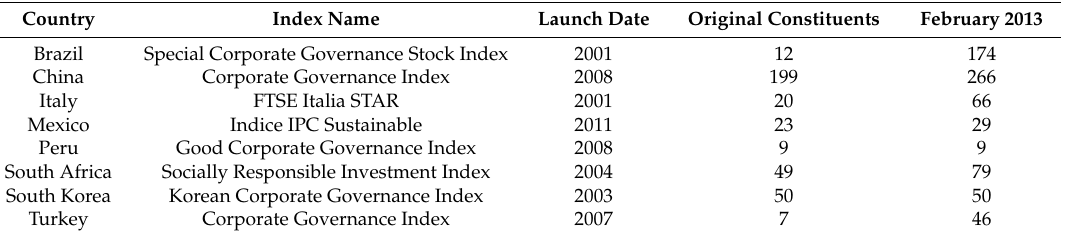
Table 1. Number of Companies Listed In Corporate Governance Indices in the